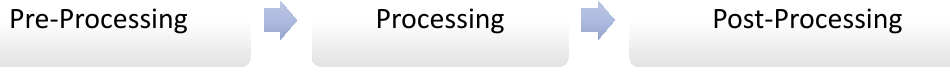
Figure 22. The steps for the finite element method.